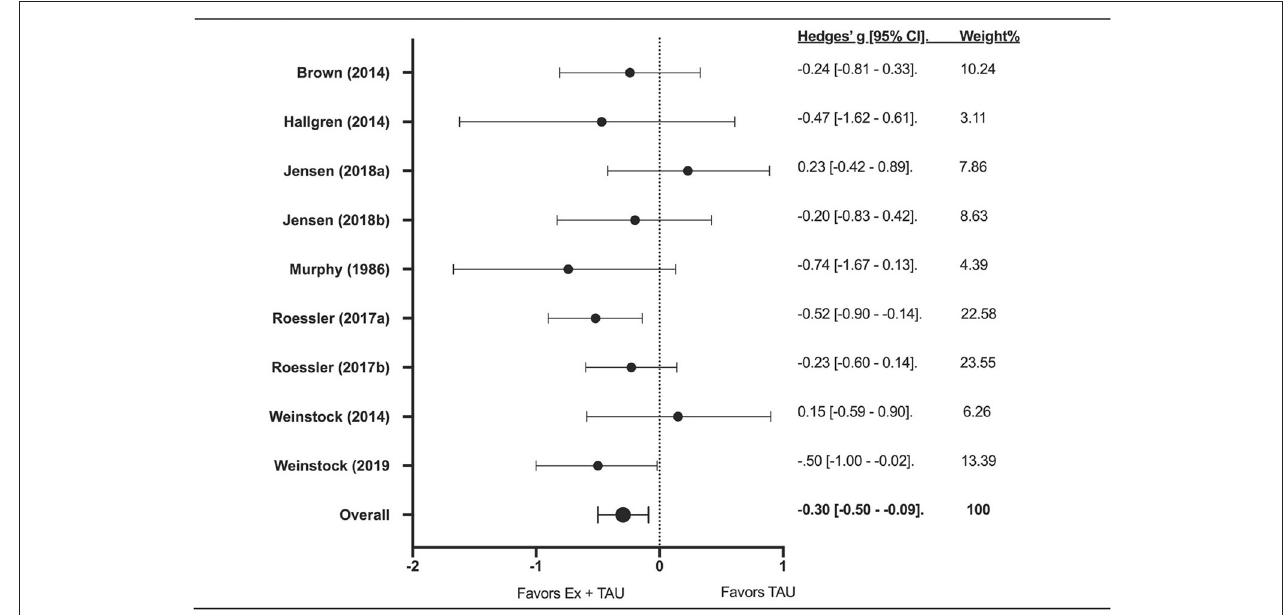
FIGURE 2 | The forest plot about the effect of exercise on drinking volume.